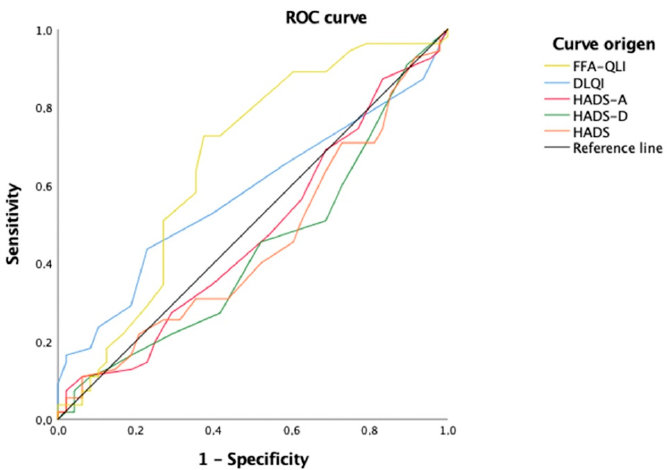
Figure 1. Receiver operating characteristic (ROC) curve to assess discriminative power differences between scales to select severe FFA. The FFA-QLI showed higher discriminative power to discriminate patients with severe FFA, compared to all the other questionnaires, the DLQI, HADS, HADS-A, and HADS-D. To select patients with mild, moderate, and severe QoL impairment, cut-off points were delimited by comparing the values for the FFA-QLI and DLQI. The DLQI was used because it yielded the best correlation values. The ROC curve analysis showed that values lower than 21 in the FFA-QLI corresponded to patients with low QoL impairment, with a